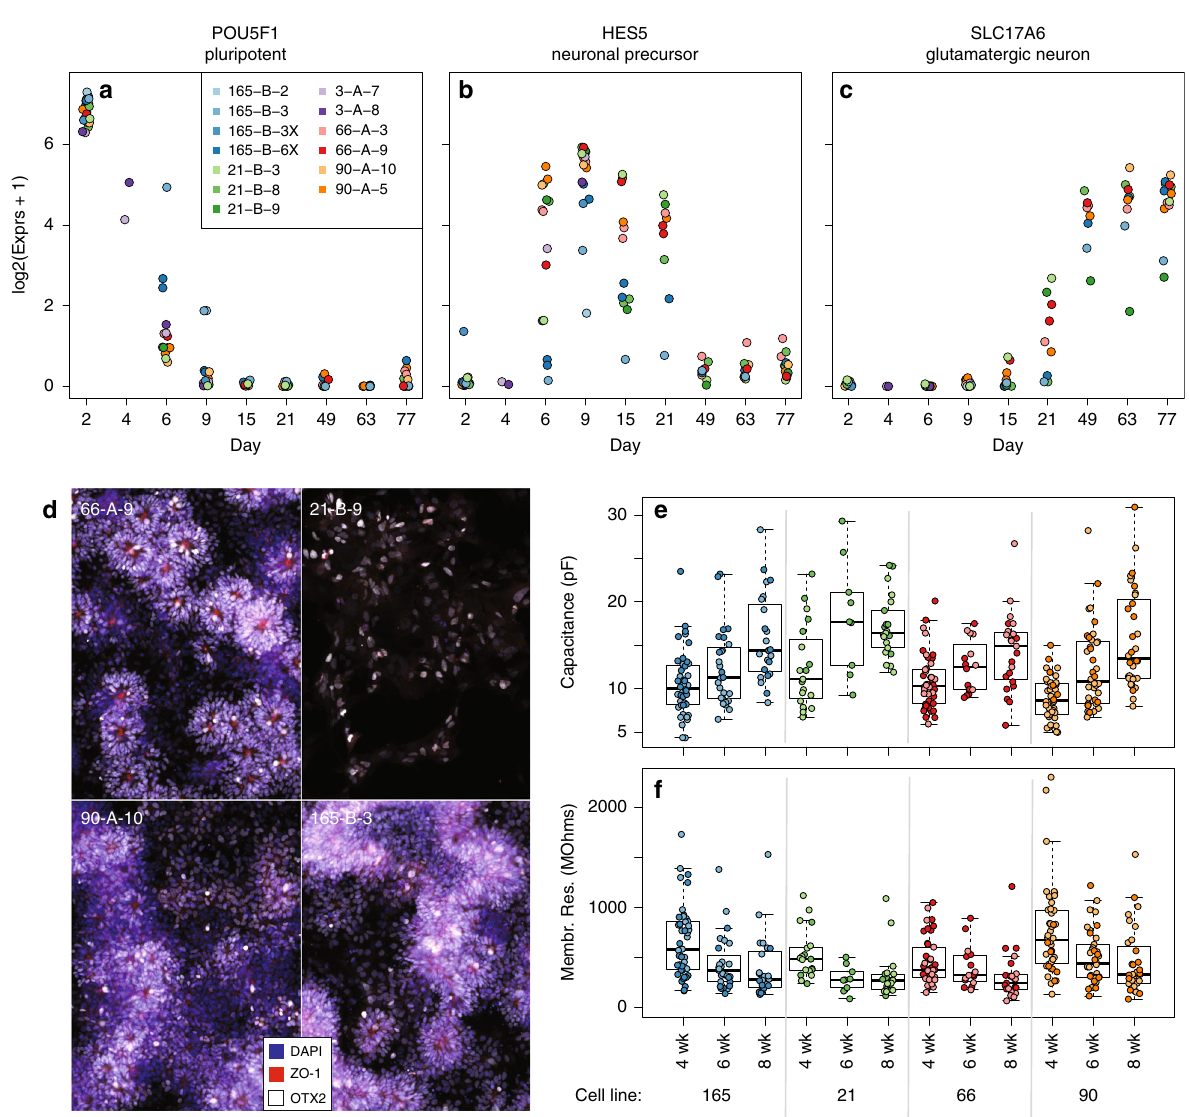
Fig. 1 Differentiating hiPSCs follow expected trajectories of neuronal development. Normalized expression levels from RNA-seq showing the expected temporal behavior of canonical marker genes through differentiation: a the loss of pluripotency gene POU5F1/OCT4 , b the expression of HES5 through NPC differentiation, and c the gain of SLC17A6/VGLUT2 through neural maturation. d Presence of self-aggregating neural rosettes using representative images from one subclonal line across four donors. Lines clockwise from top left: 66-A-9, 21-B-9, 165-B-3, and 90-A-10. Blue — DAPI; red — ZO-1; white — OTX2. Electrophysiology measurements across neuronal maturation show e increasing capacitance and f decreasing membrane